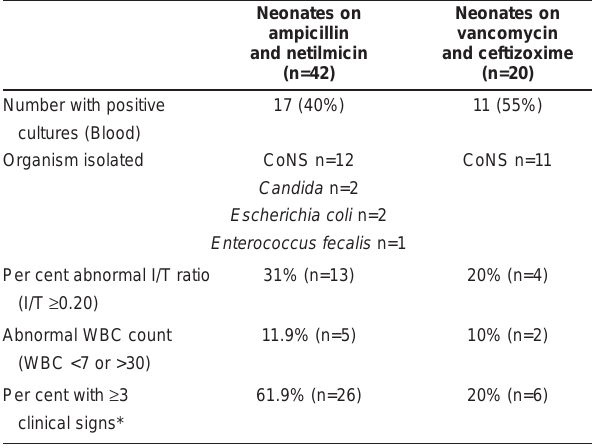
Neonates on Neonates on ampicillin vancomycin and netilmicin and ceftizoxime (n=42)